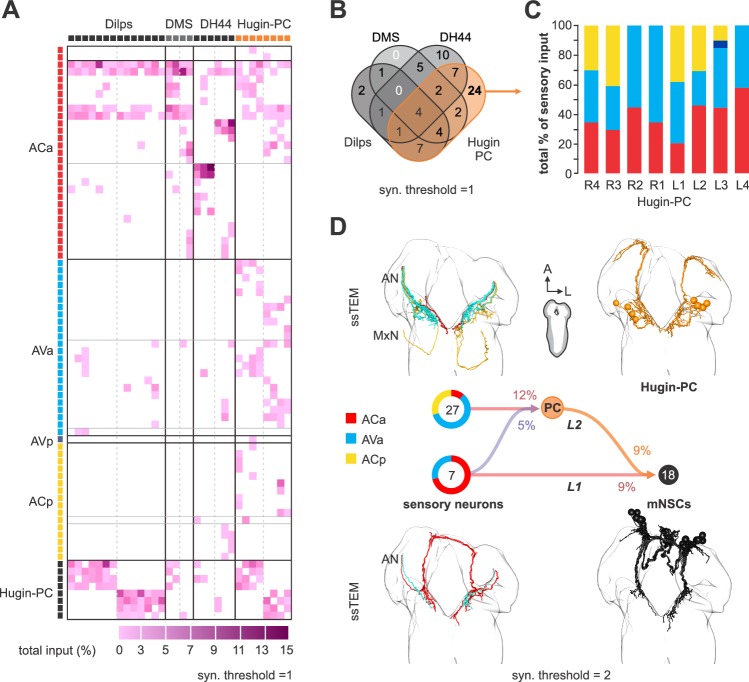
Connectivity between presynaptic sensory neurons of mNSCs and huginPC neurons.(A) Adjacency matrix showing sensory-to-mNSCs and huginPC connectivity, color-coded by percentage of inputs on mNSC and huginPC dendrites. Sensory neurons are ordered based on synapse similarity score (sensory compartments, Figure 2); they are listed based on their connectivity patterns to their targets. Dotted lines separate left and ride targets. (B) Venn diagram shows overlaps and differences between presynaptic sensory neurons of the different target groups. (C) Sensory profile of each individual huginPC neuron. On average 80% of the total incoming synaptic load from sensory neurons made by enteric sensory neurons, and 20% by pharyngeal and external sensory neurons. (D) Summarizing representation of all seven monosynaptic sensory-to-mNSCs paths, which concurrently use huginPC neurons as an alternative route to target the mNSCs using a synaptic threshold of 2. HuginPC neurons receive sensory information from 27 other sensory neurons, thus integrating a completely different set of sensory neurons onto a basic reflex circuit. Figure shows EM reconstructions of respective neuron groups.